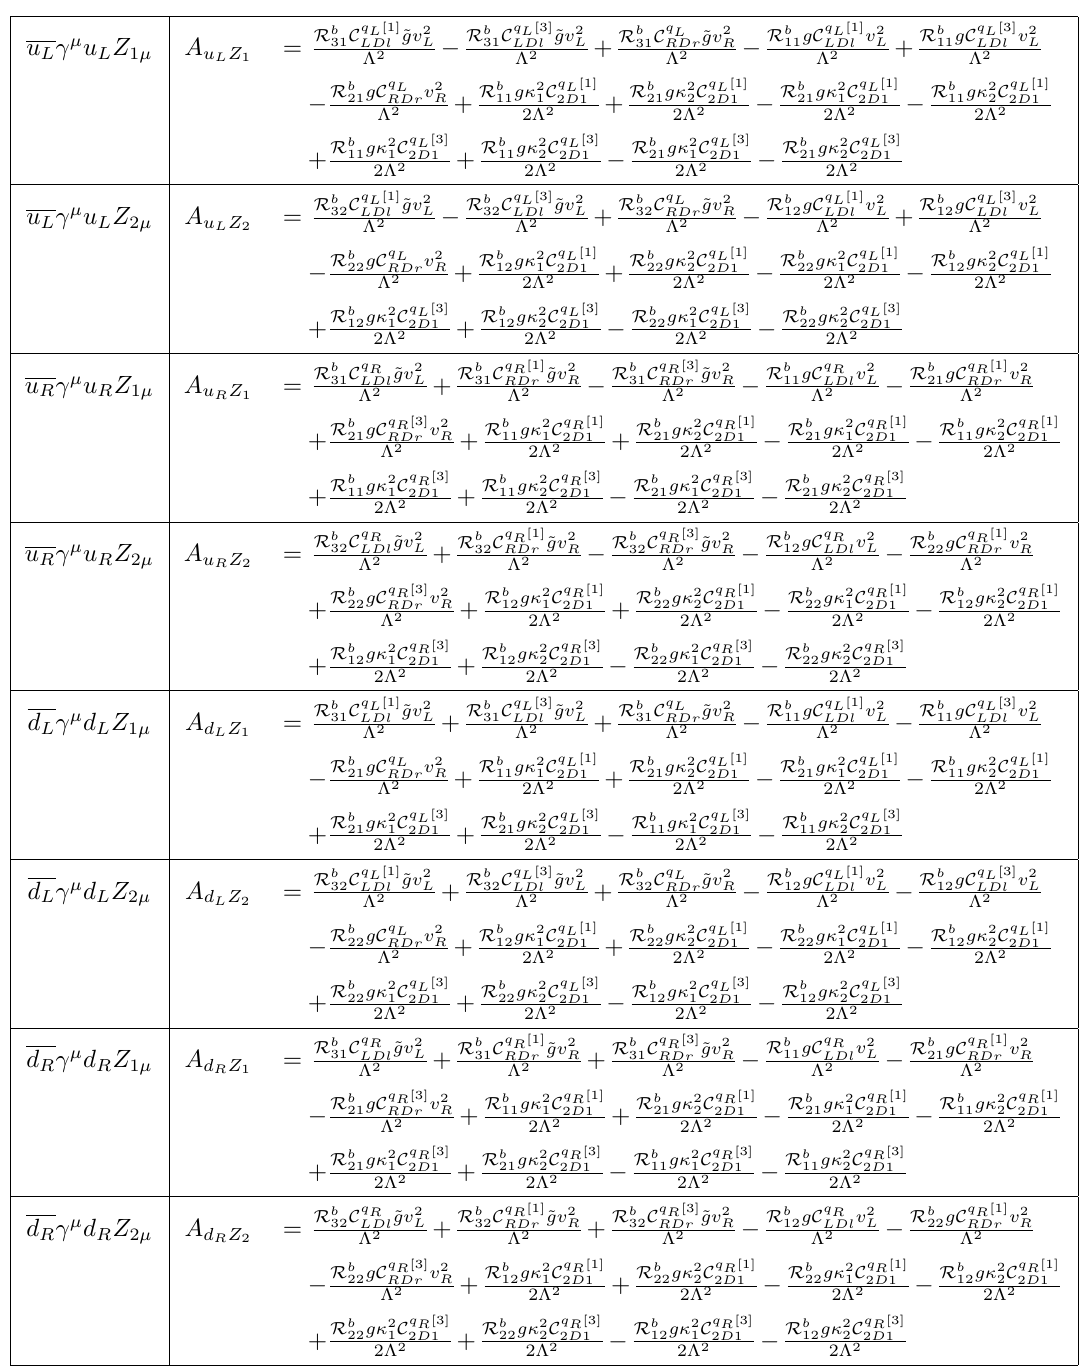
Table 34. Table 33 continued.